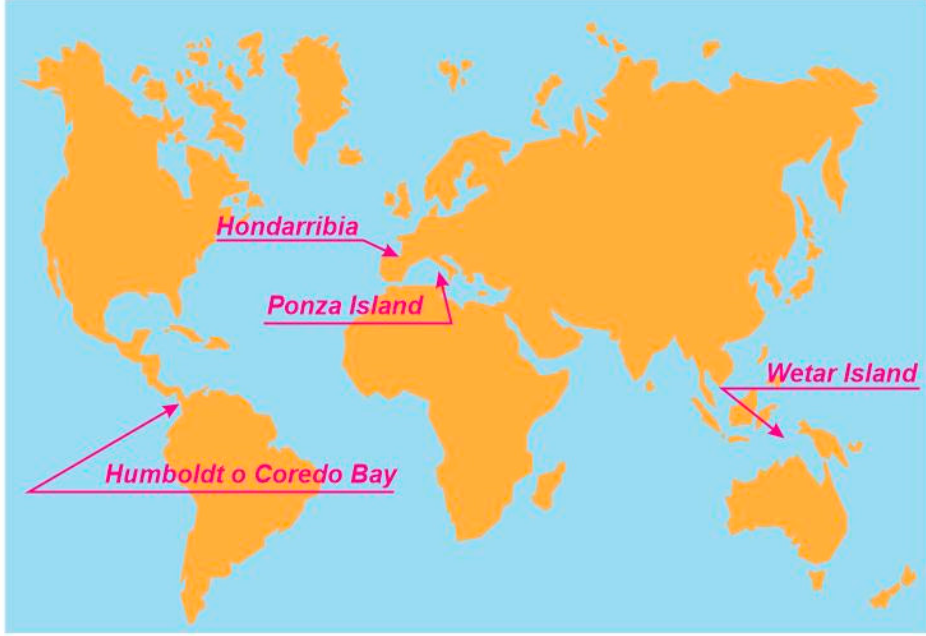
Figure 1. New localities of coastal megaclast deposits considered in this paper.